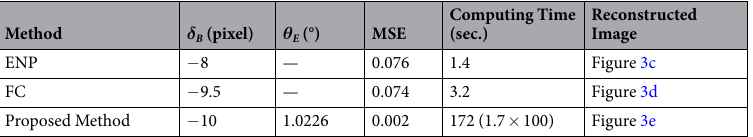
Table 2. Results of applying ENP, FC, and the proposed method to Phantom